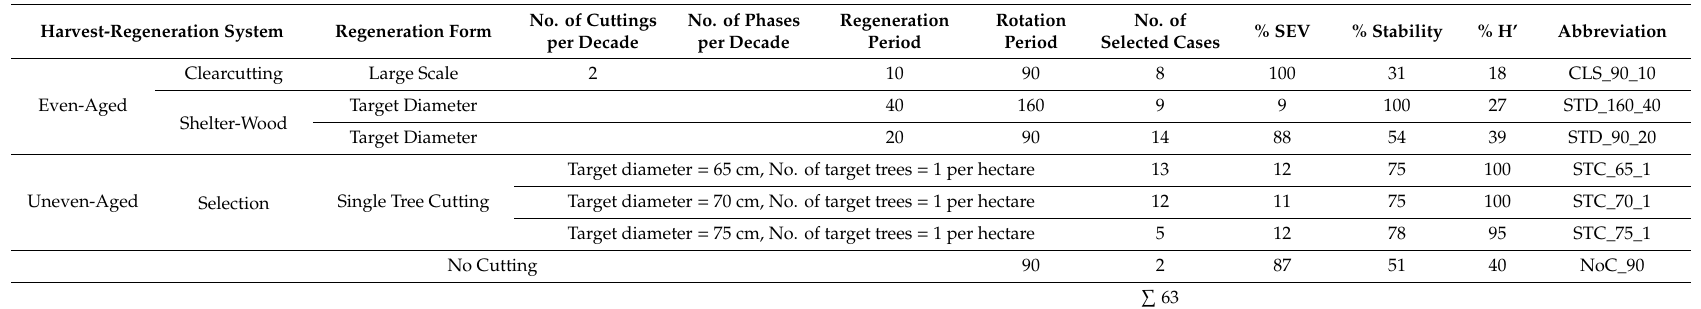
Table 3. List of variants with the highest sums of scores that occurred within 63 best variants identified for di ff erent combinations of criteria weights by the weighted summation method. Percentage values (% SEV, % Stability, and % H’) were calculated as a ratio of the actual value of the criteria achieved under particular management variant to the maximum value from 450